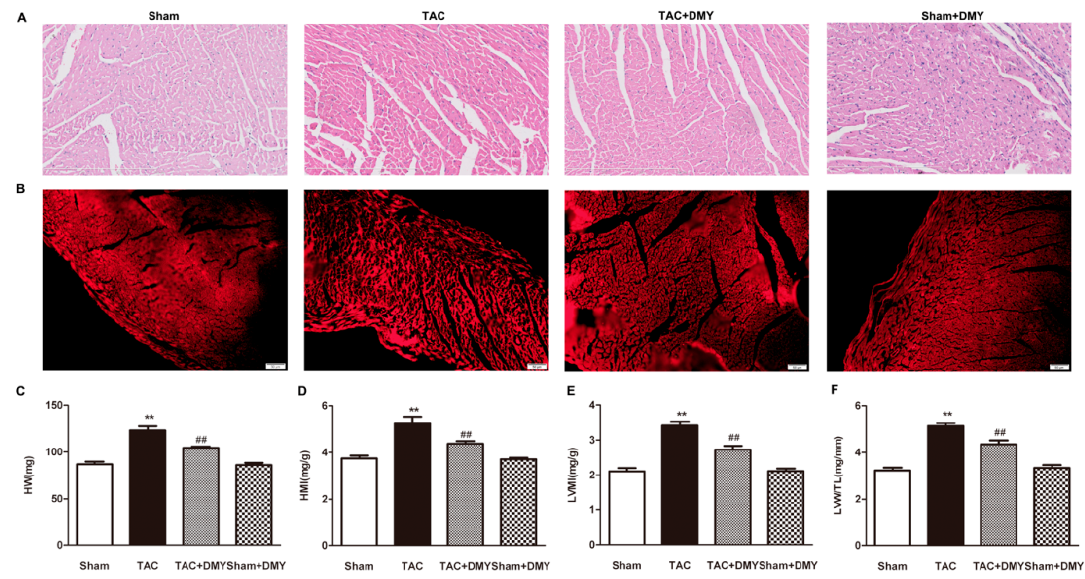
Figure 4. Effect of DMY on cardiomyocyte cross-sectional area and cardiac index in mice after TAC. ( A ) Representative images of hematoxylin and eosin (HE) staining of the myocardium were shown. Bar = 300 μ m. ( B ) Representative images of wheat germ agglutinin (WGA) staining of the mice myocardium were shown. Bar = 50 μ m. ( C – F ) Heart weight (HW), heart mass index (HMI), left ventricular mass index (LVMI) and LVW/TL were calculated. ** p < 0.01 versus Sham, ## p < 0.01 versus TAC ( n = 8).